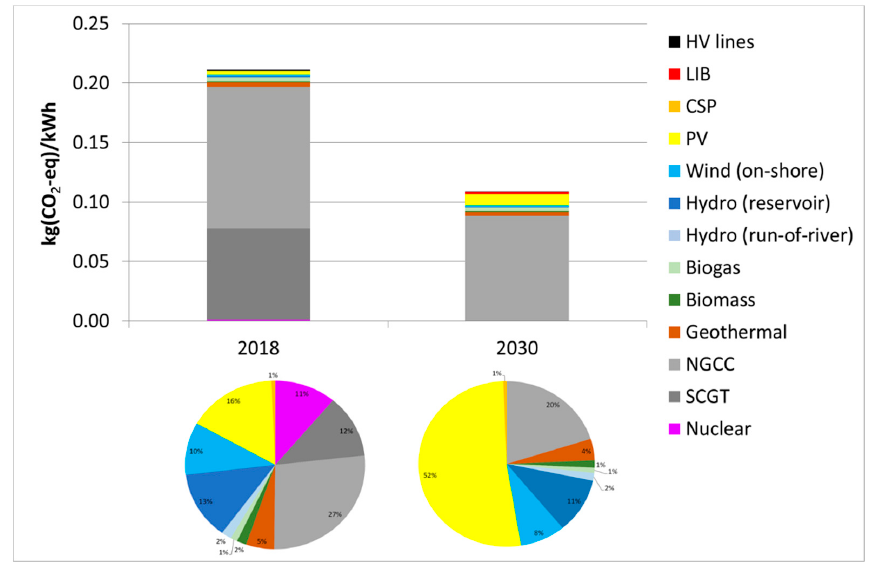
Figure 7. Global warming potential (GWP) results for California domestic grid mix in 2018 and in 2030. The pie charts underneath each bar refer to the corresponding grid mix composition, and are included to aid the interpretation of the results. SCGT = single cycle gas turbines; NGCC = natural gas combined cycles; PV = photovoltaics; CSP = concentrating solar power; LIB = lithium-ion batteries; HV = high voltage.